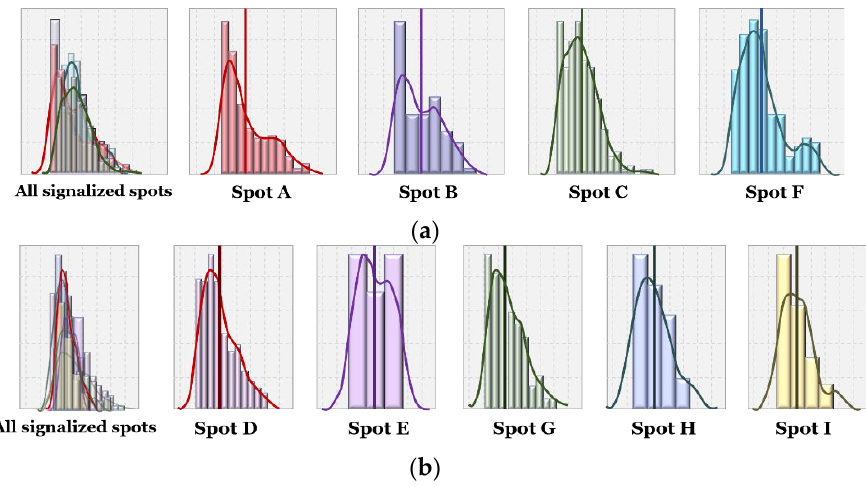
Figure 15. Distributions of PSMs in ( a ) signalized spots, and ( b ) unsignalized spots. Meanwhile, in unsignalized crosswalks, the overall distributions are similar to each other, and we did not observe a relationship between road width and PSM distribution.